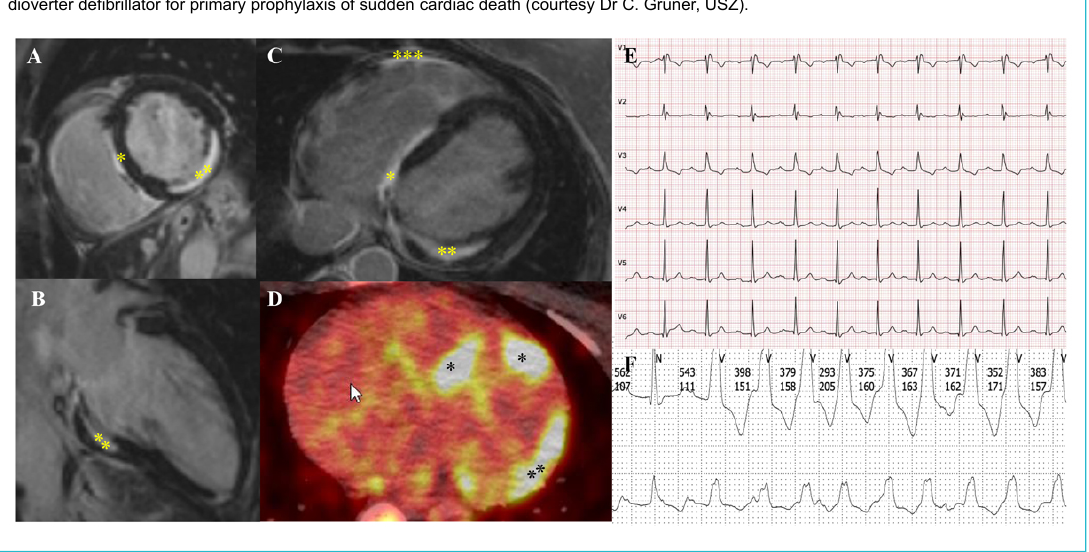
Figure 3: 51-year-old woman with sarcoidosis and cardiac involvement. A–C demonstrates myocardial fibrosis in the interventricular septum (*), inferolateral wall (**) and the right ventricle (***) on cardiac magnetic resonance imaging. D shows the corresponding cardiac FDG-PET/CT with mild inflammation of the septum (*) and the lateral wall (**). E: Her ECG shows a compromised conduction system with first degree atri- oventricular block (PQ time 264 ms) and complete right bundle branch block. F: She had repeated nonsustained ventricular tachycardia on